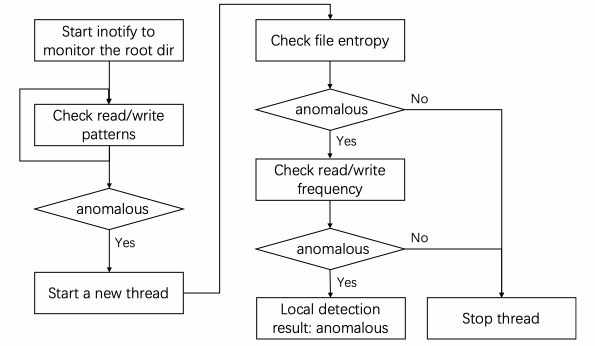
Figure 2. Workflow of local detection